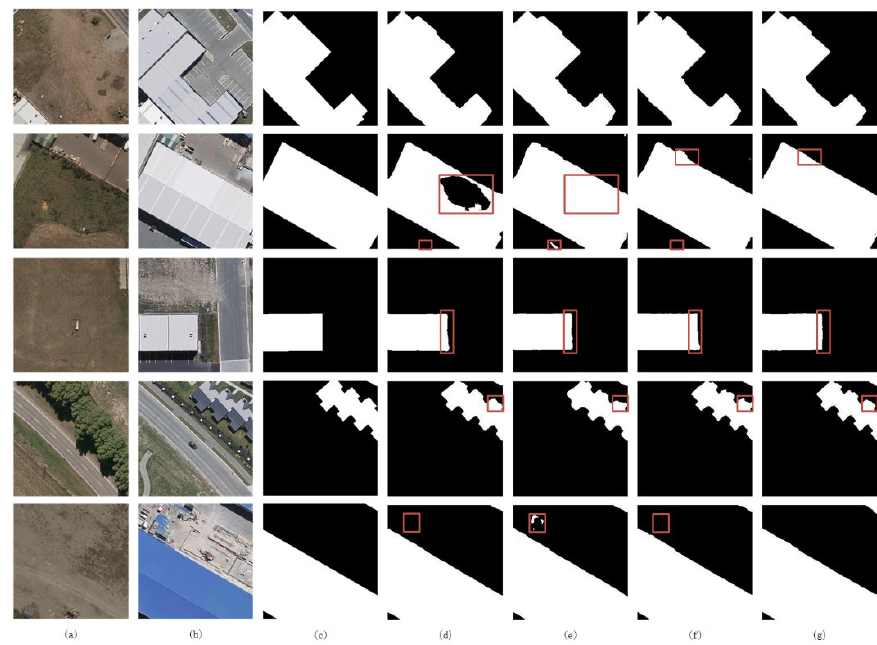
Figure 11. Results of ablation experiments on the WHU-CD dataset. ( a ) Pretemporal images. ( b ) Posttemporal images. ( c ) Ground truth images. ( d ) Results of the base model. ( e ) Results of CTNet. ( f ) Results of CTINet. ( g ) Results of EGCTNet. We highlight the differences in the results with red rectangles. (Ref boxes highlight areas in the image with significant differences.)